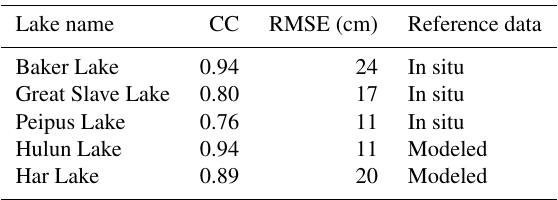
Table 3. Validation/cross-validation metrics of altimetry-based LIT in five study